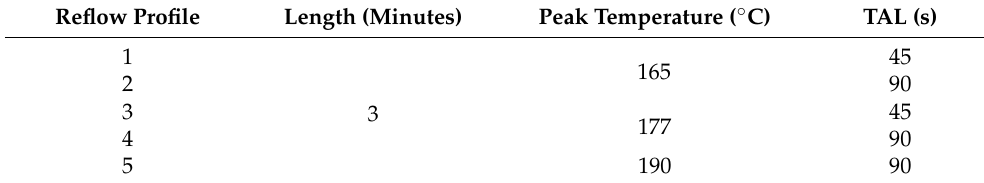
Table 2. RTS reflow profiles studied in this